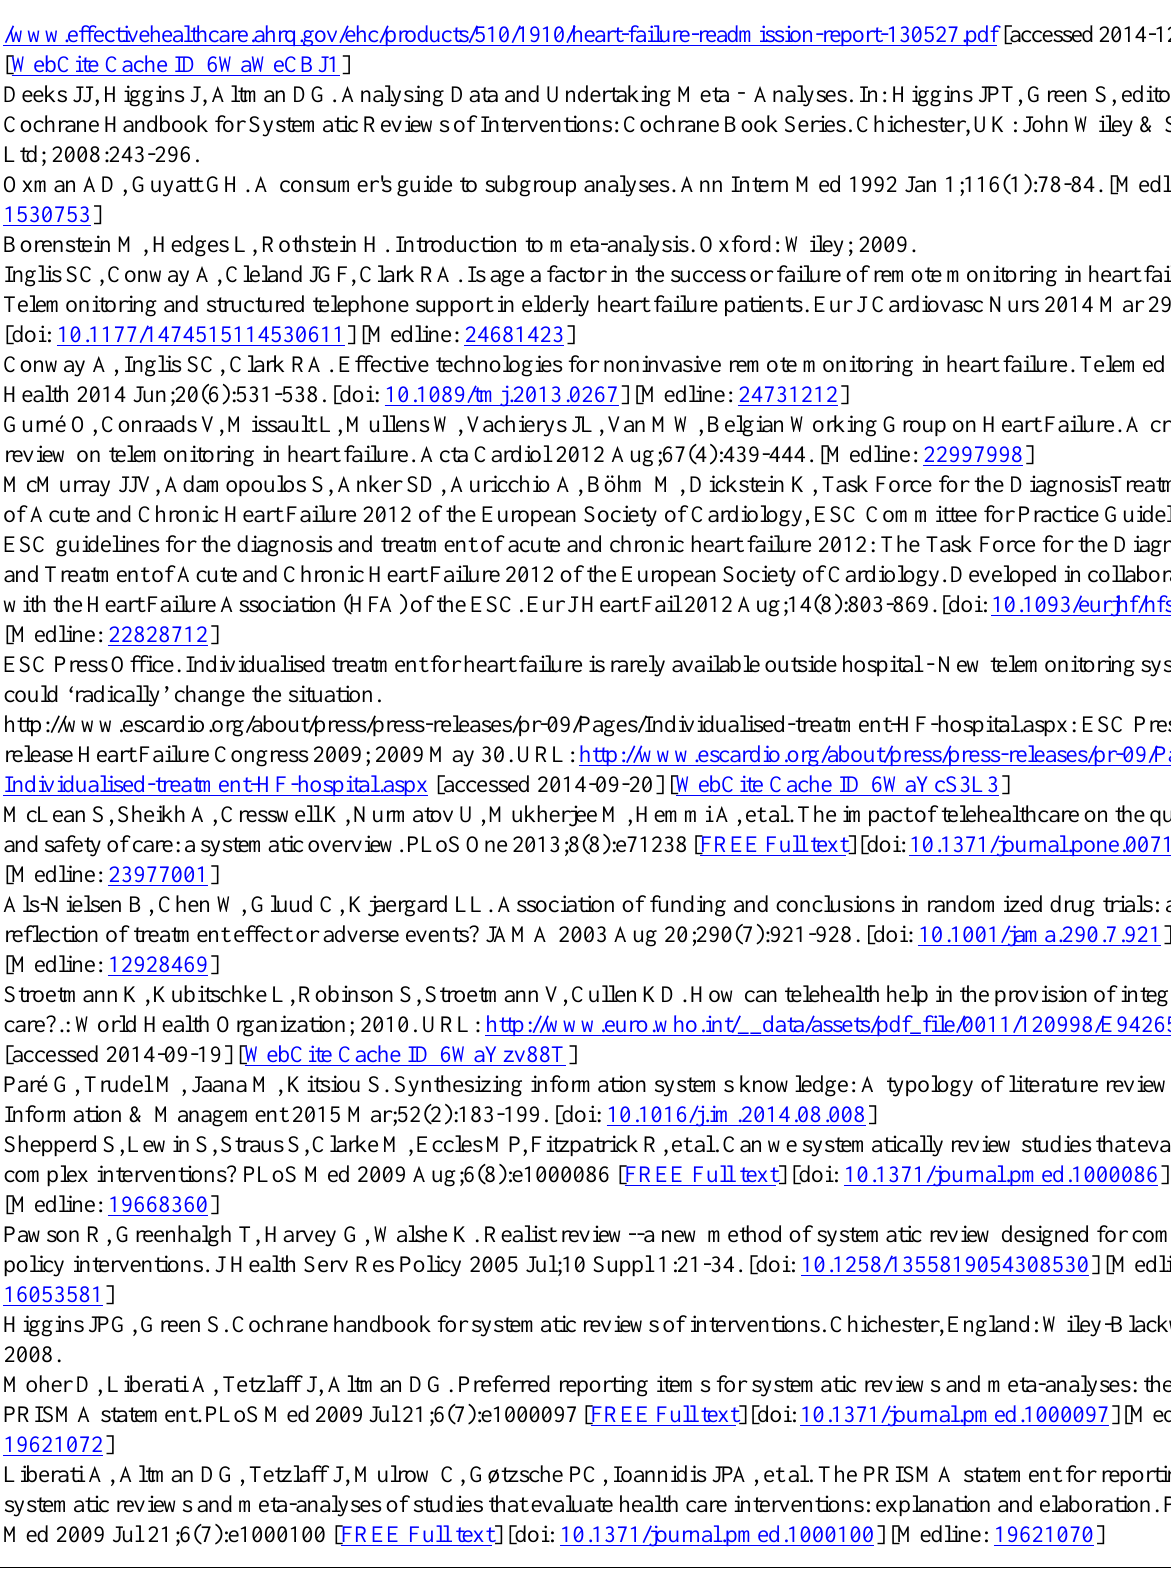
Abbreviations AMSTAR: Assessment of Multiple Systematic Reviews ARR: absolute risk reduction CI: confidence interval Crl: credible interval GRADE: Grading of Recommendations Assessment, Development, and